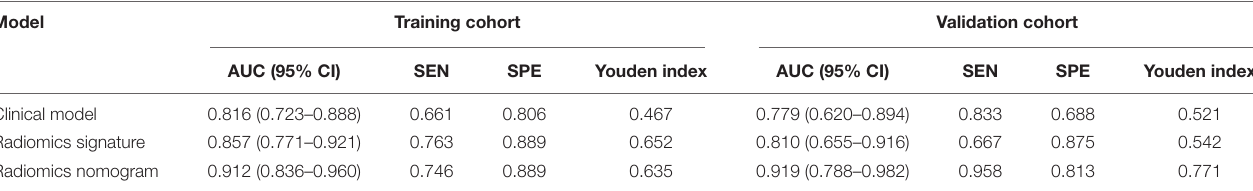
FIGURE 3 | The radiomics nomogram for predicting the status of hemorrhage and calibration curves. (A) The radiomics nomogram, combining age, location, and radiomics signature were developed in the training cohort. Patients with younger age ( < 50 years) or hemorrhages located in lobes and the negative radiomics signature were more likely to be vascular malformations-related hemorrhage (VMH). (B,C) Calibration curves for the radiomics nomogram in the training and validation cohorts. Calibration curves indicated the agreement of the nomogram between the predicted risk of VMH and actual status. The 45 ◦ gray dotted line represents the ideal prediction and the black curve is the predictive performance of the nomogram. The closer the black curve is to the gray dotted line, the better is the predictive efficacy of the nomogram. TABLE 3 | Predictive performance of radiomics nomogram, radiomics signature, and clinical model. Model Training cohort Validation